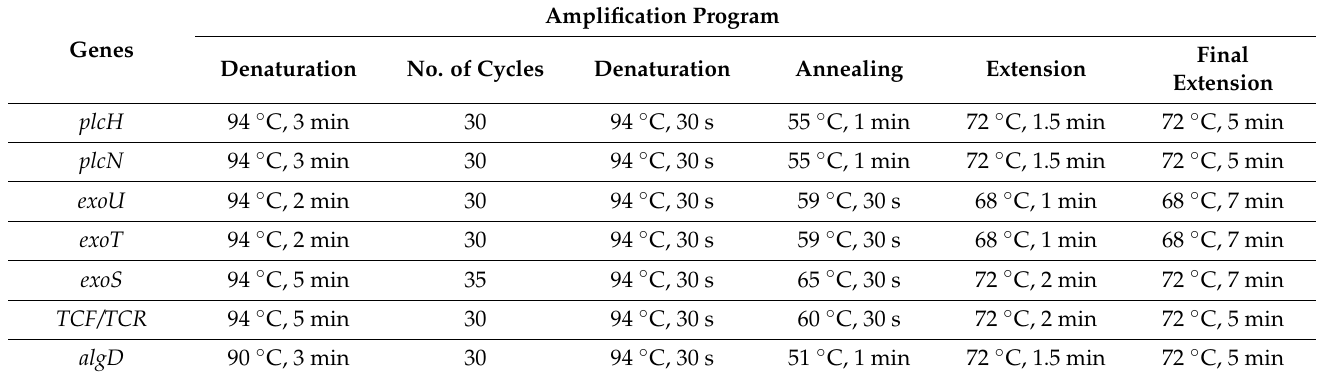
Table 3. Amplification program for virulence genes.